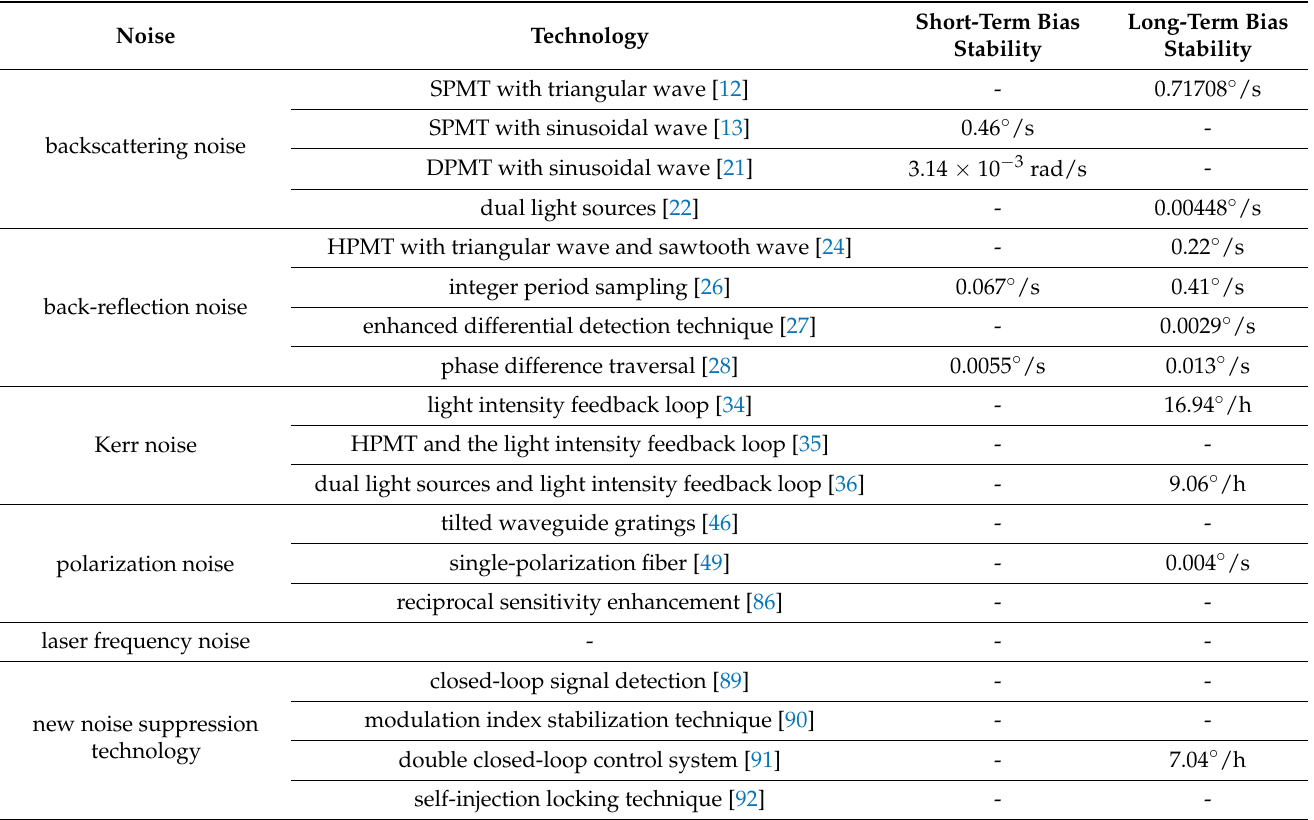
Table 1. Main noise suppression